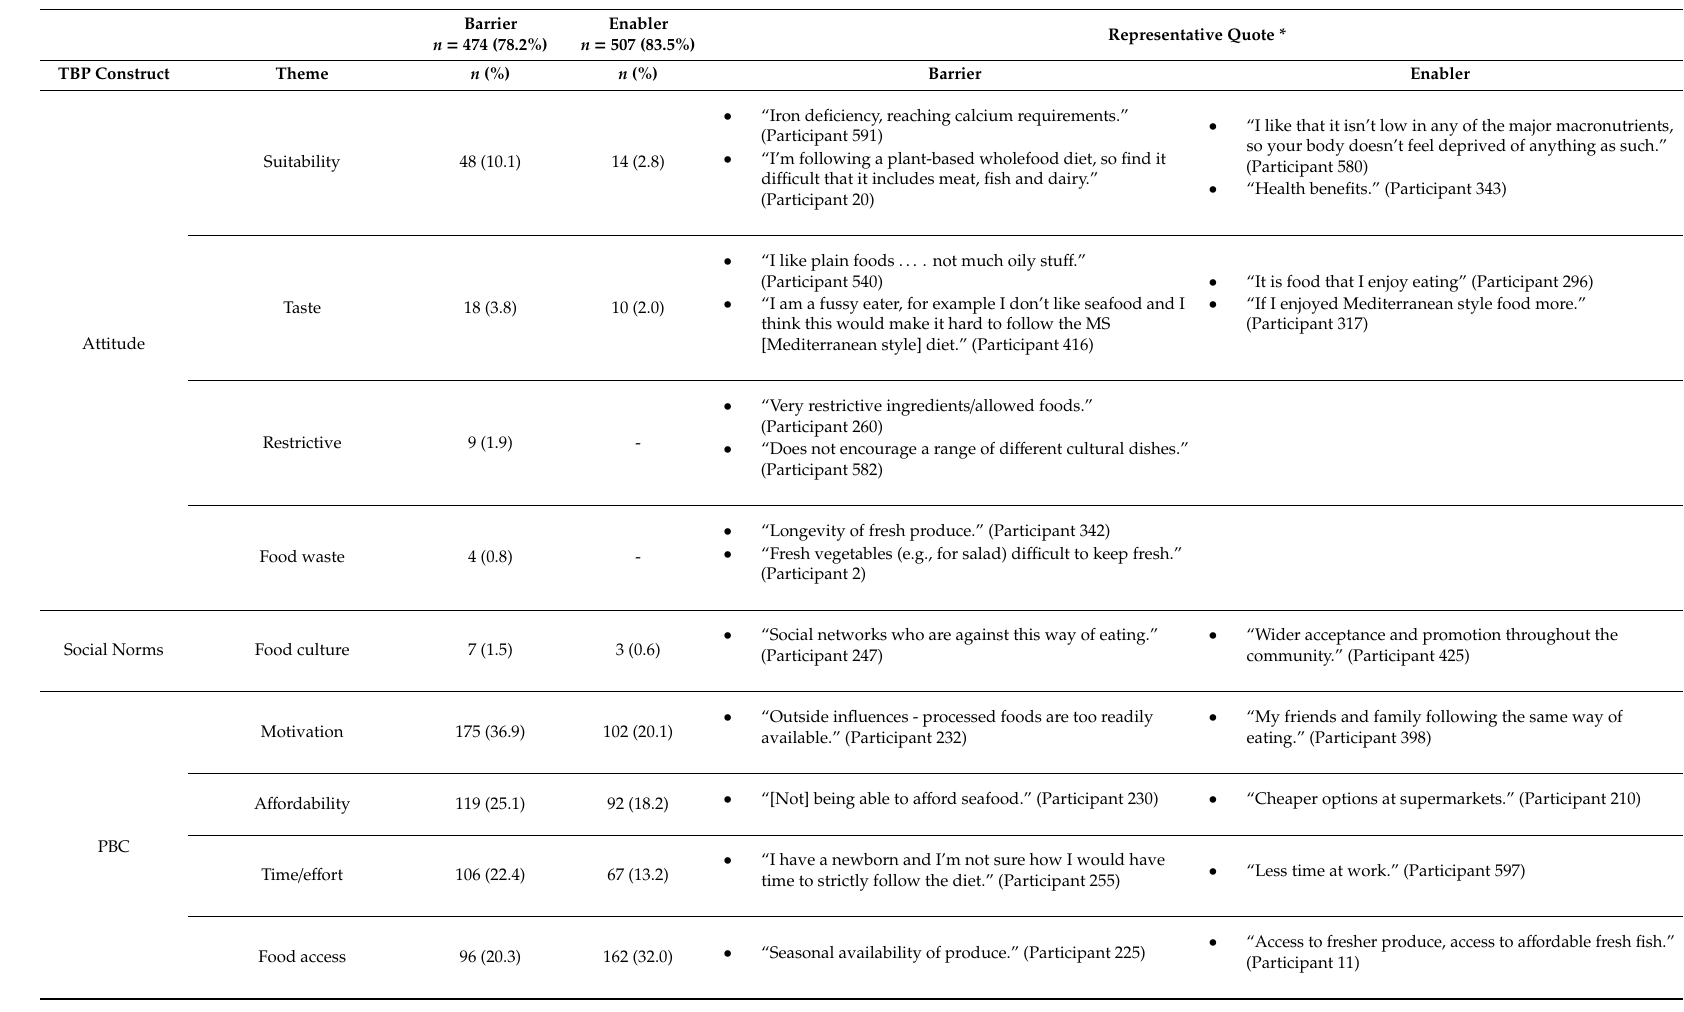
Table 4. Barriers and enablers for following a Mediterranean diet, reported by Australian